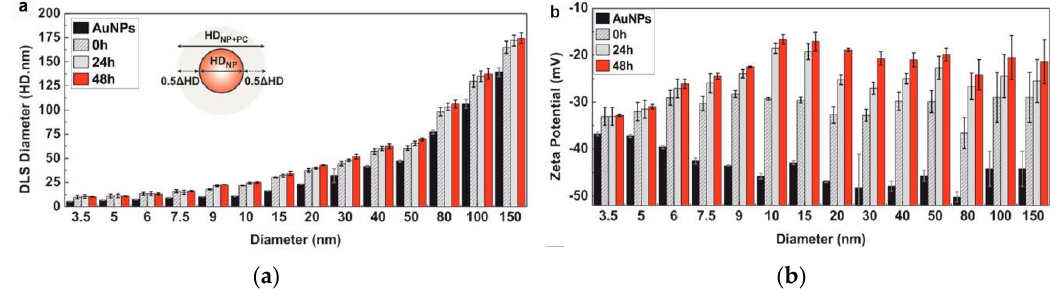
Figure 2. Dynamic light scattering (DLS)-measured hydrophobic diameter (HD) ( a ) and zeta potential ( b ) of purified Au nanoparticles (NPs) of different sizes after their exposure to cCCM for different times. Reprinted with permission from [10]. Copyright (2017) American Chemical Society.